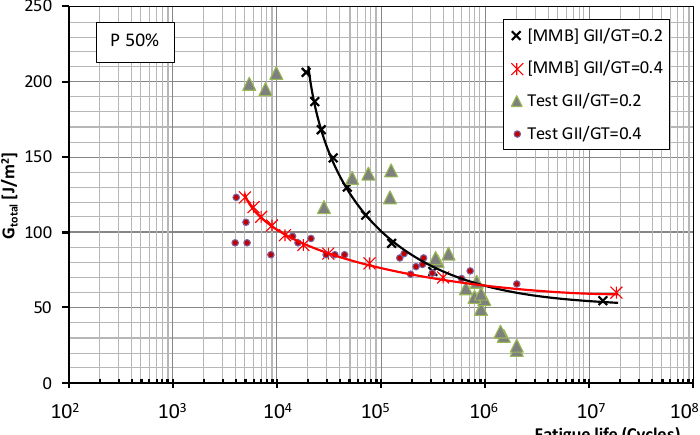
Figure 4. Material fatigue curves, MMB test, for a 50% probability of fracture and two mode mixity ratios: 0.2 and 0.4.